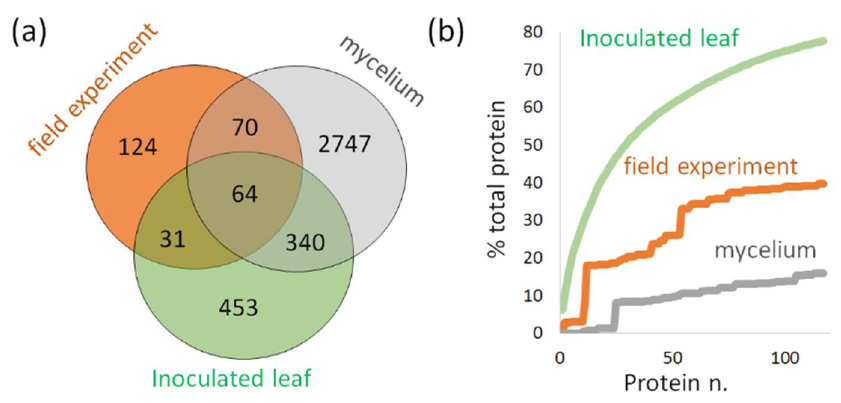
Figure 9. The comparison of P. infestans proteins found in all three datasets. ( a ) The overlap between identified P. infestans proteins and ( b ) the contribution of the most abundant P. infestans proteins found in the inoculated detached leaves (green) to the total Phytophthora protein content in leaves from the field experiment (orange) and mycelium (gray). See Supplementary Table S12 for details.